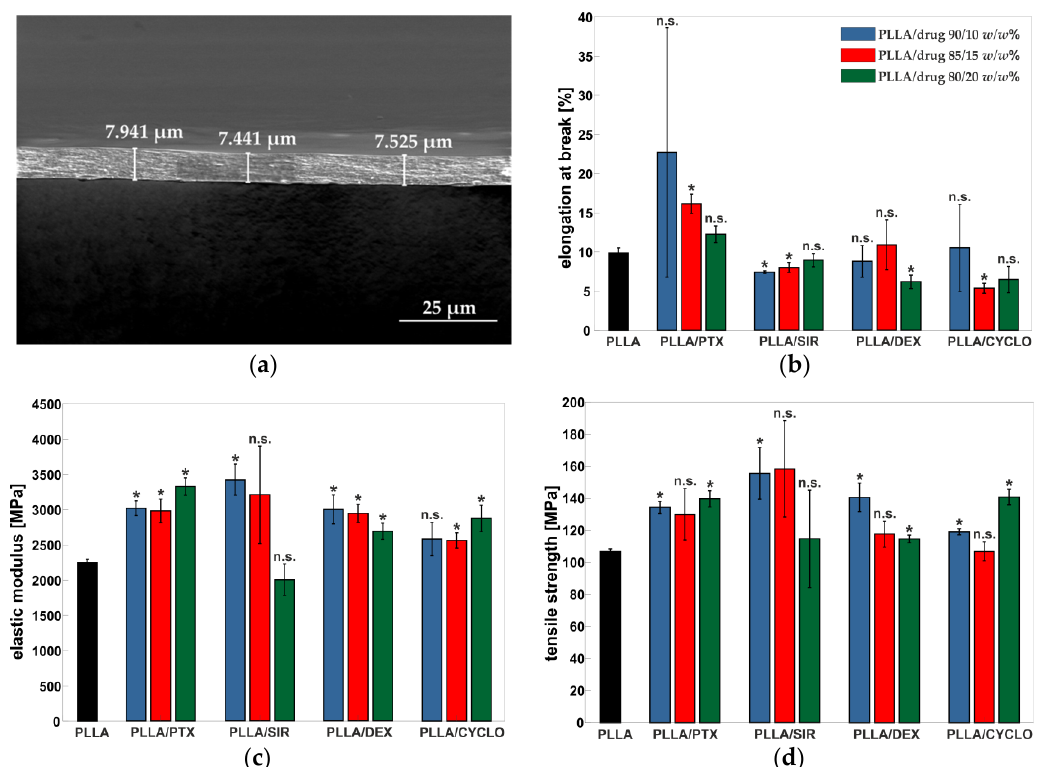
Figure 8. ( a ) Exemplary SEM image of PLLA reference film with determined thicknesses. ( b–d ) Mechanical properties (( b ) elongation at break, ( c ) elastic modulus and ( d ) tensile strength), determined from uniaxial tensile tests of PLLA/drug spray coated films in different drug ratios (90/10, 85/15 and 80/20 w / w %). Asterisks (*) mark significant differences of the values with p < 0.05 obtained by two-tailed t -test, each in comparison to PLLA reference. n.s. stands for not significant.